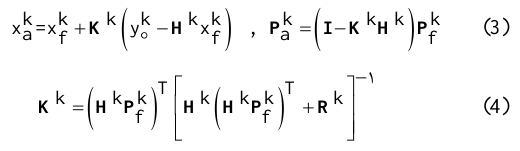
Figure 1. Variables and operators involving at